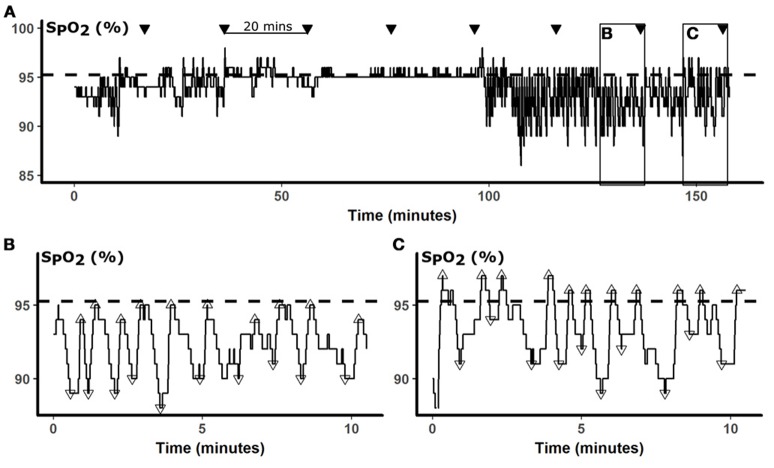
Data analysis. In (A), a representative 160-min SPO2 is presented. The baseline SPO2 calculated from the mean SPO2 while treated with CPAP is represented by the dashed horizontal line. During sleep studies, glucose was measured every 20 min (▾). To examine SPO2 predictors of glucose, we analyzed oximetry during the 10 min preceding each glucose measurement, as illustrated by boxes in (A) and shown in greater details in (B,C). SPO2 nadirs (▿) and peaks (Δ) were identified by automated peak detection. The desaturation depth and subsequent overshoot were calculated relative to the baseline. Panel (B) illustrates a period of frequent desaturations, which were followed by only partial restoration of oxygenation, resulting in negative overshoot. In contrast, Panel (C) illustrates repetitive desaturations were followed peaks that exceeded the baseline, resulting in positive SPO2 overshoots, despite desaturations were of similar depths.